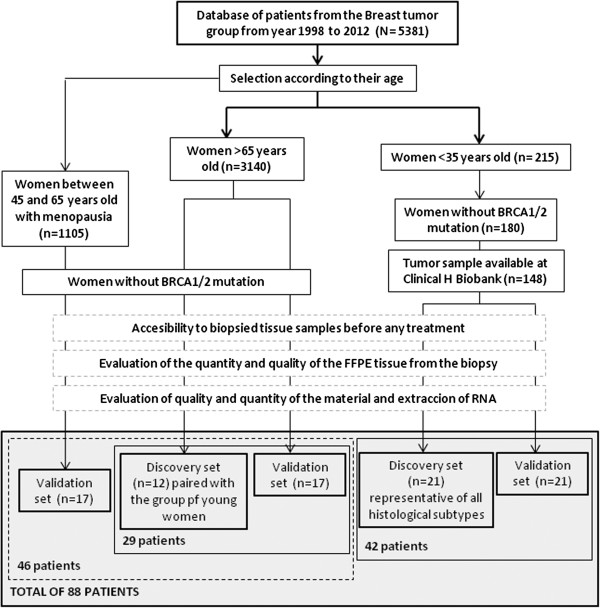
Flow diagram representing the guidelines followed in the selection of the patients suitable for the present study.